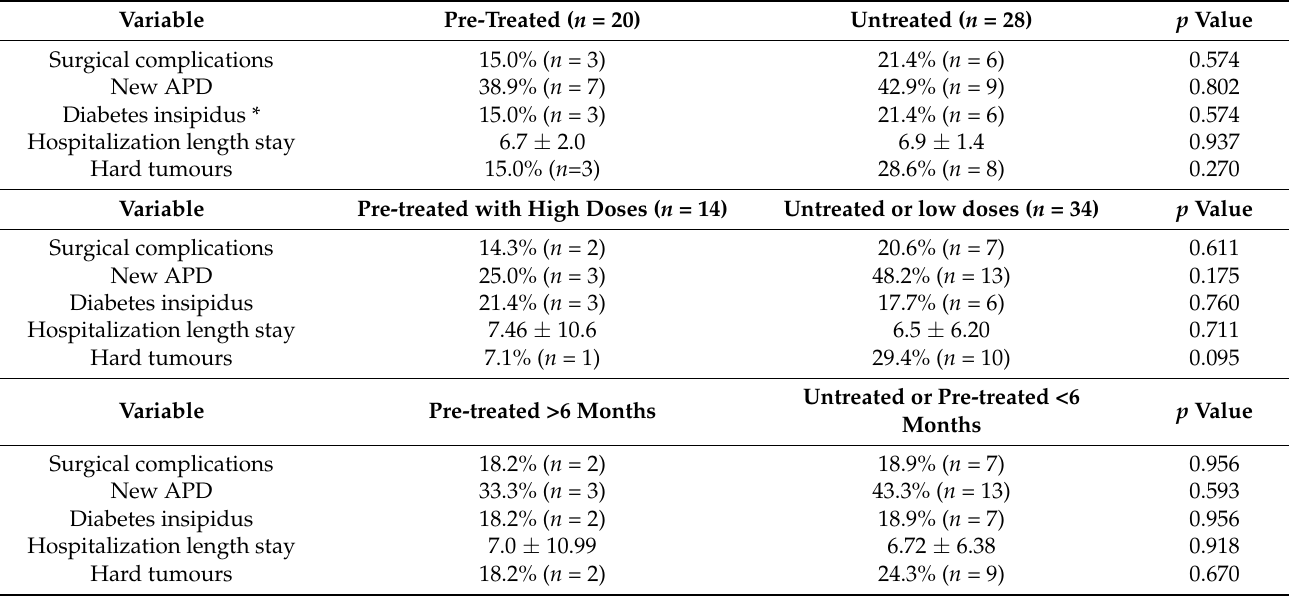
Table 3. Surgical and endocrine morbidity in pre-treated with somatostatin analogues and untreated.